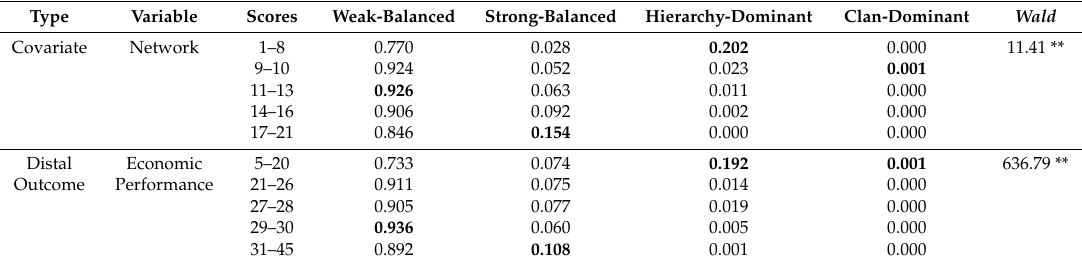
Table 4. Multinomial regression presenting associations between latent profile membership and external variables (First model: economic performance).